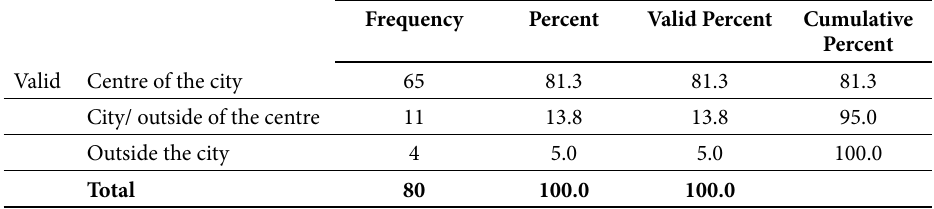
Table 2. Location of the surveyed tourism enterprises, 2004